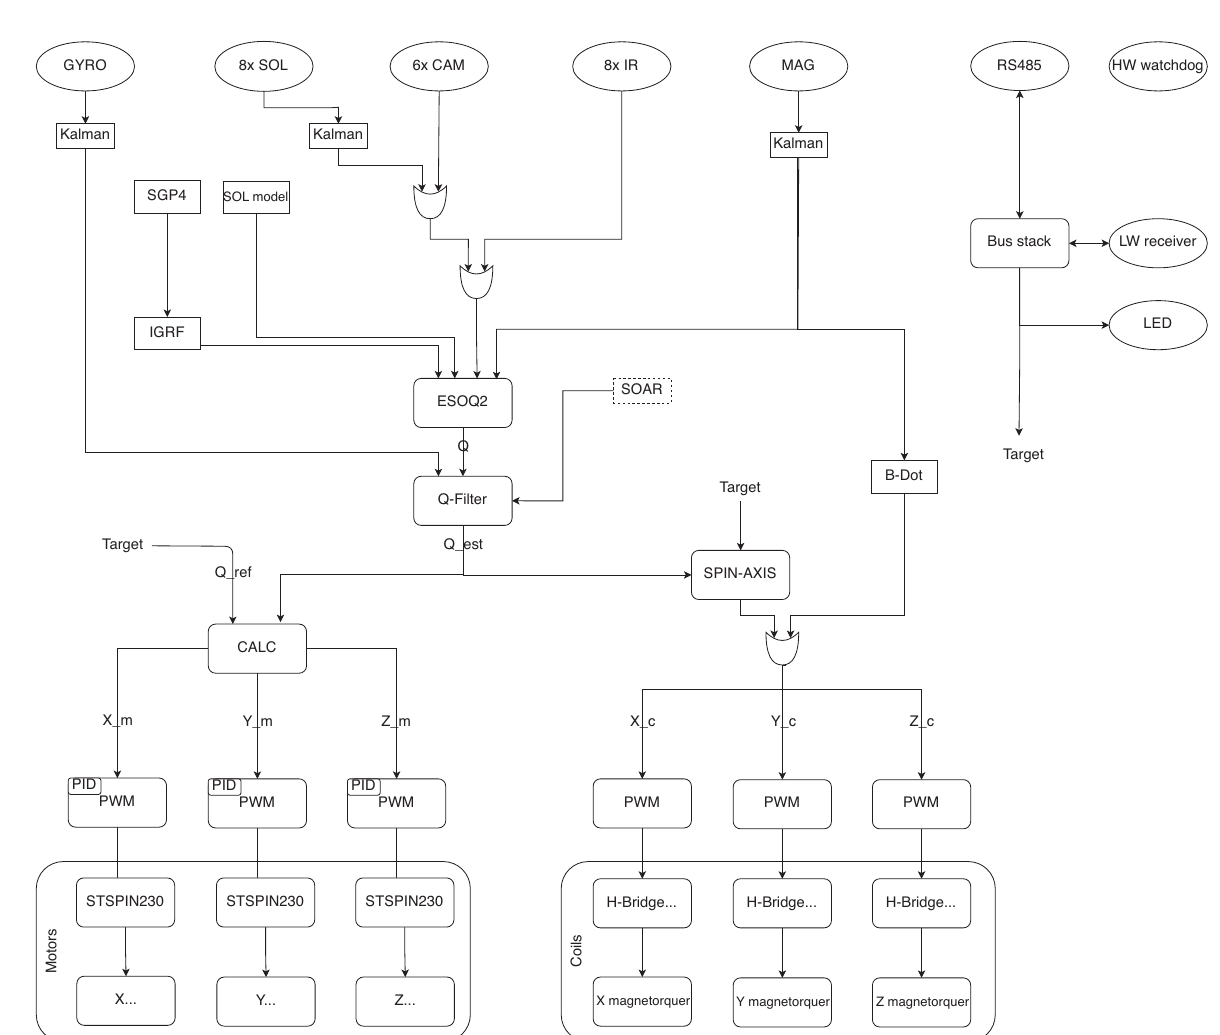
Fig. 9. ADCS diagram of the TTU100 satellite: GYRO – Gyroscope; SGP4 – Simplified perturbations model; IR – Infrared sensor; SOL – Solar sensor; MAG – Magnetic sensor; CAM – Camera; IGRF – International Geomagnetic Reference Field; HW (hardware) watchdog (is an electronic or software timer that is used to detect and recover from computer malfunctions); LW – Longwave (radio receiver); ESOQ2 – Estimator of the optimal quaternion; Q – Quaternion; Q-Filter – Quaternion filter; B-Dot – Detumbling algorithm; SOAR – Satellite Ocean Aerosol Retrieval (algorithm to cover water